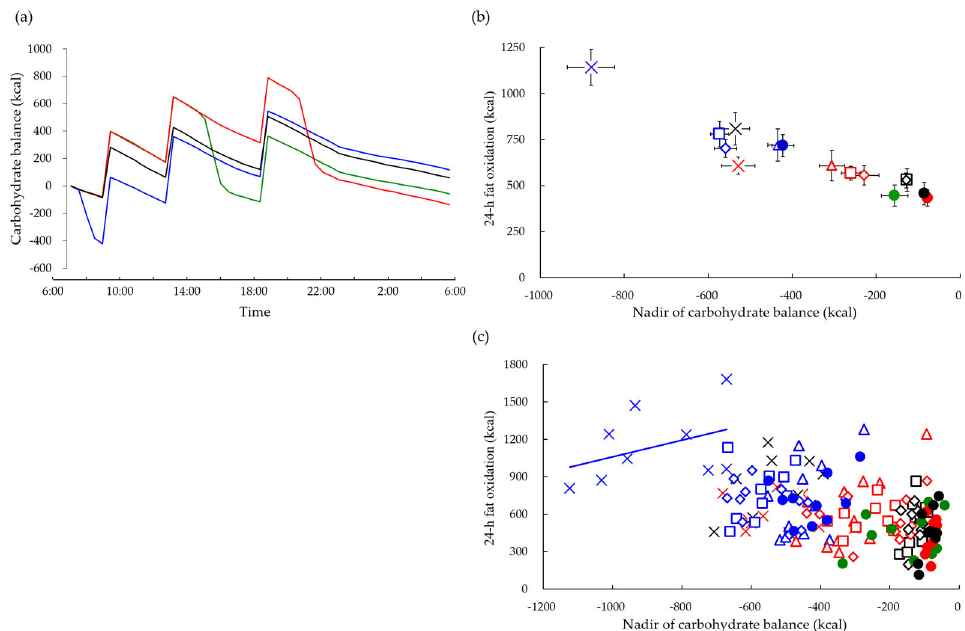
Figure 5. Carbohydrate balance and 24 h fat oxidation. ( a ) Carbohydrate balance relative to the start of 24 h calorimetry was estimated as the difference between input (meal consumption) and output (carbohydrate oxidation) for control ( ― ), morning exercise ( ― ), afternoon exercise ( ― ), and evening exercise ( ― ) [46]. ( b ) Relationship between nadir of carbohydrate balance and 24 h fat oxidation for control ( ● ), morning exercise ( ● ), afternoon exercise ( ● ), and evening exercise ( ● ) [46]. Data from our previous studies were also plotted: 12 males completed two trials of 60 min of exercise at 50% VO 2max before ( ▵ ) or after ( ▵ ) breakfast [47], 9 males completed three trials of 100 min of exercise at 65% VO 2max before breakfast (×) or after lunch (×), and 50 min each before breakfast and after lunch (×) [48], 10 males completed three trials of 60 min of exercise at 60% VO 2max before breakfast ( □ ) and after lunch ( □ ) or non ‐ exercise control ( □ ) [49], 11 males completed three trials of 60 min at 60% VO 2max before breakfast ( ◊ ) and after lunch ( ◊ ) or non ‐ exercise control ( ◊ ) [50]. The correlation coefficient was − 0.44 ( n = 154; p < 0.01). ( c ) Criteria of nested data (i.e., 0.1 < ICC), namely the intraclass correlation coefficients (ICC) of transient carbohydrate deficits, and 24 h fat oxidation were 0.87 and 0.39, respectively. Transient carbohydrate deficits exhibited significant a negative association with 24 h fat oxidation in between experiments (B = − 0.73, 95% CI: − 0.87, − 0.58). However, within the experiment, transient carbohydrate deficits show a significant positive association with 24 h fat oxidation (B = 1.35, 95% CI: 0.94, 1.76) [52]. As an example, the regression line is shown only for the trial in which 100 min of exercise at 65% VO 2max was performed before breakfast.